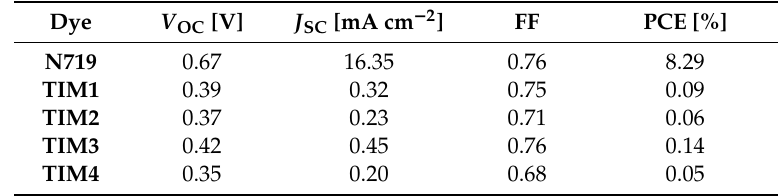
Figure 6. J-V curves of the dye-sensitized solar cells using TIM1 – 4 series as the light absorber. Table 3. Summary of the device performance for the champion cells. The data for N719 dye are shown as a